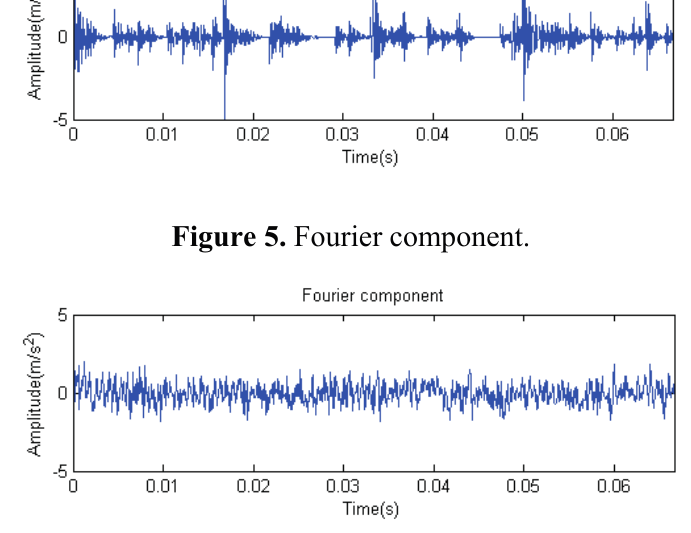
Figure 6. Modulation